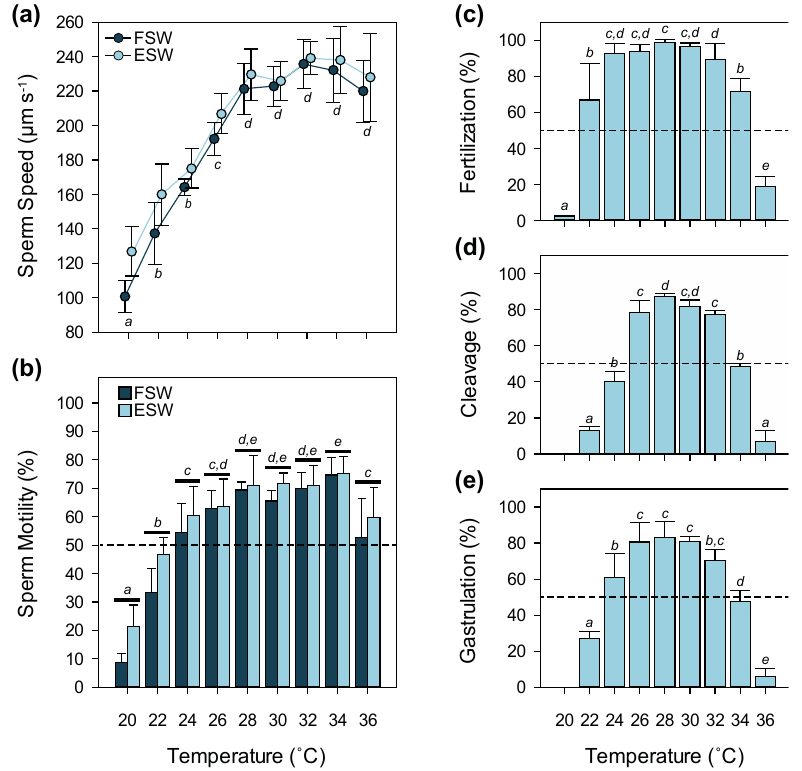
Figure 2. Thermal tolerance of sperm, fertilization, and embryonic development: ( a ) sperm speed (points slightly displaced for clarity); ( b ) sperm motility; ( c ) fertilization; ( d ) cleavage; and ( e ) gastrulation ( n = 5). Letters next to error bar caps (± SD) indicate significant differences based on post hoc pairwise comparisons with corrected p- values. FSW = 0.2- μ m filtered seawater (control); ESW = solution with water-soluble egg extract.